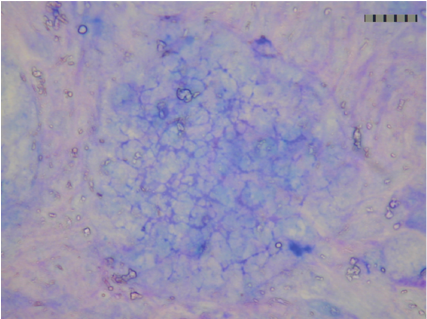
Figure 4: Mucous strings are networked substances under a microscope. Mucous granules are released from cultured mucous cell clone derived from HT-29, and mucous strings are stained blue on the cultured cell surface by AB-PAS. bar 50 μ